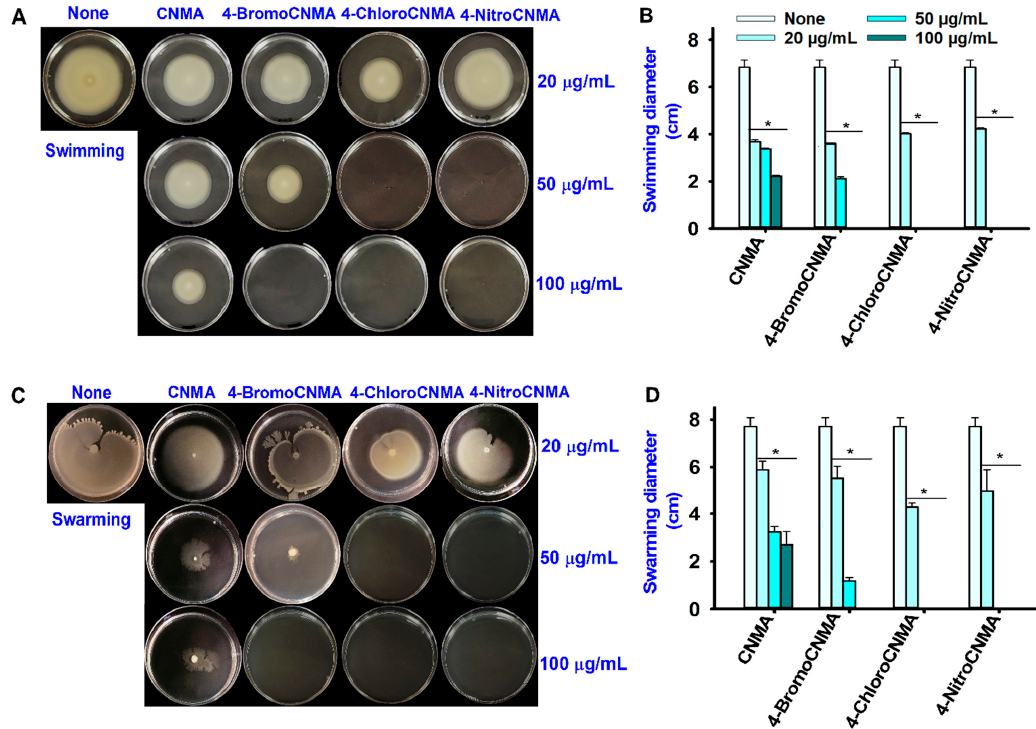
Figure 3. Effects of CNMA derivatives on the surface motility of V. parahaemolyticus. Swimming motility ( A ), swarming motility ( C ), diameter of migration in the swimming assay ( B ), diameter of migration in the swarming assay ( D ). * denotes a significant difference at p < 0.05.